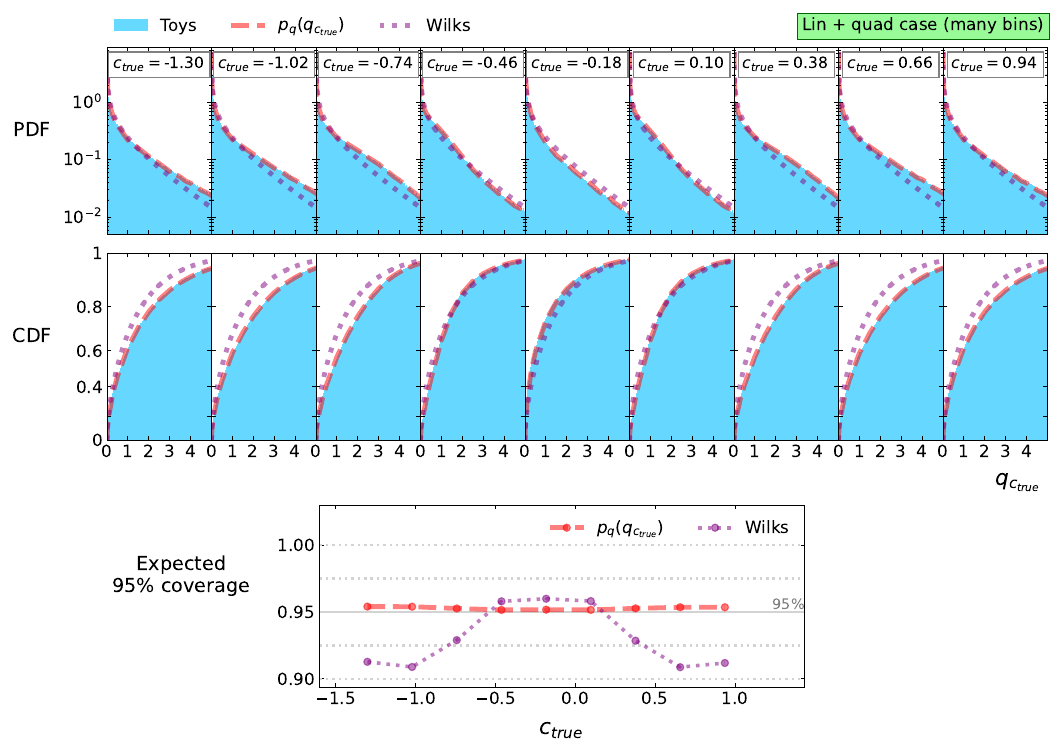
Figure 11: Distributions of the PDF and CDF along with the expected coverage for the multi-bin “linear plus quadratic” example defined by Eq